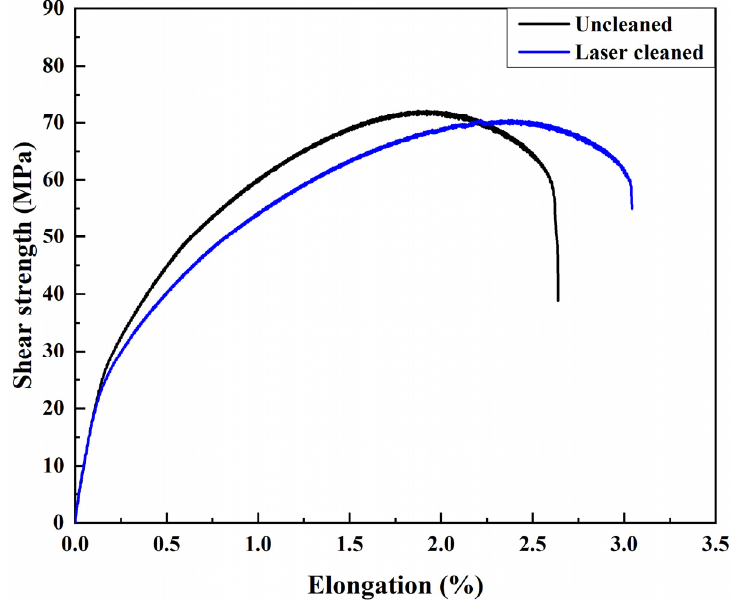
Figure 16. The shear strength of the samples before and after black ash removal.